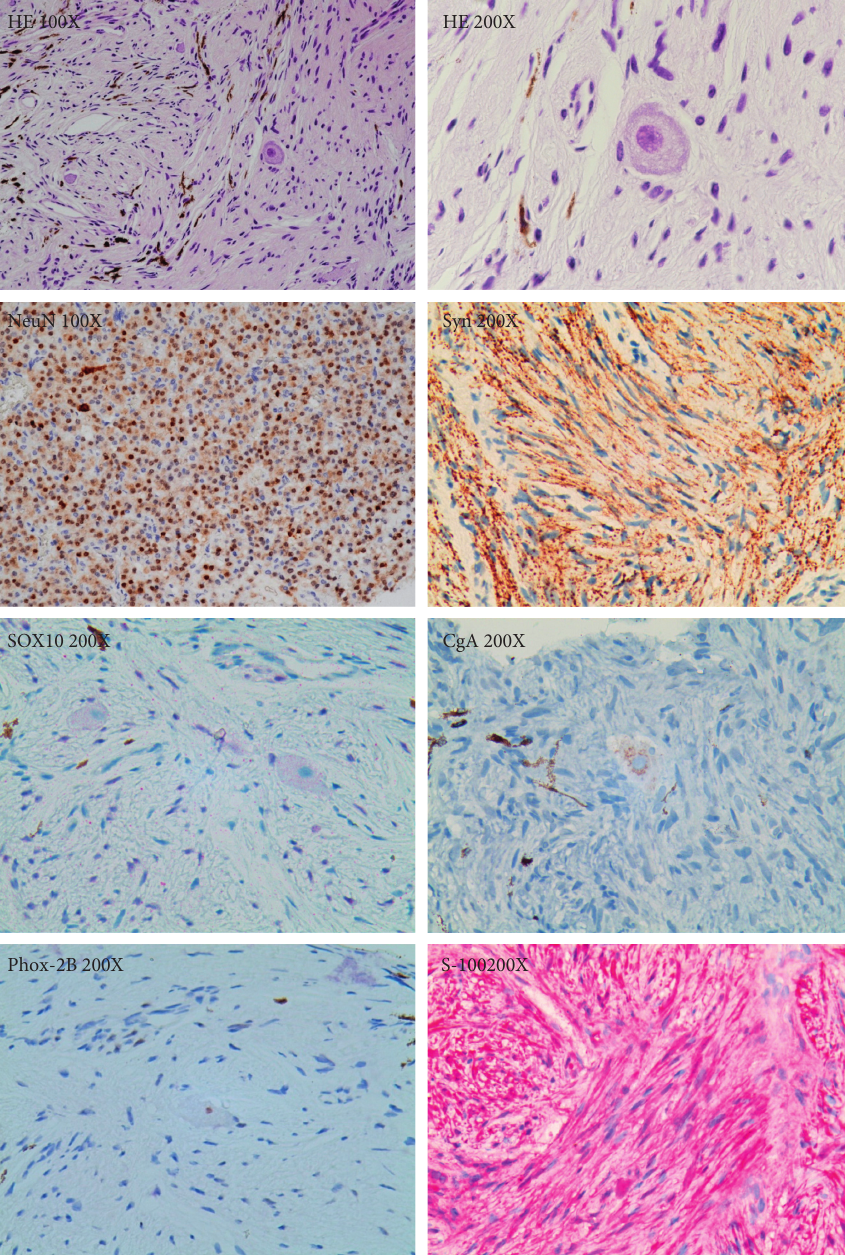
Figure 5: Histopathology of choroid biopsy. Histopathology revealed scattered ganglion and dense infiltrate spindle-shaped cells. Throughout the choroid, ganglion cells demonstrated immunostaining for neuronal markers as NeuN, SOX10, Syn, CgA, and Phox-2B. The spindle-shaped cells were strongly positive for S-100.